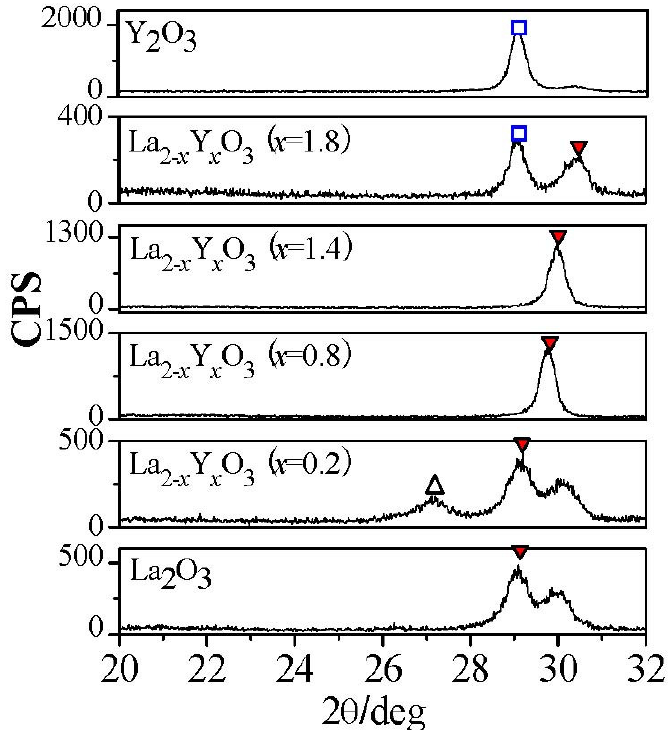
Figure 15. XRD patterns of La annealing at 600 °C. ( : Hexagonal La La O 2 3